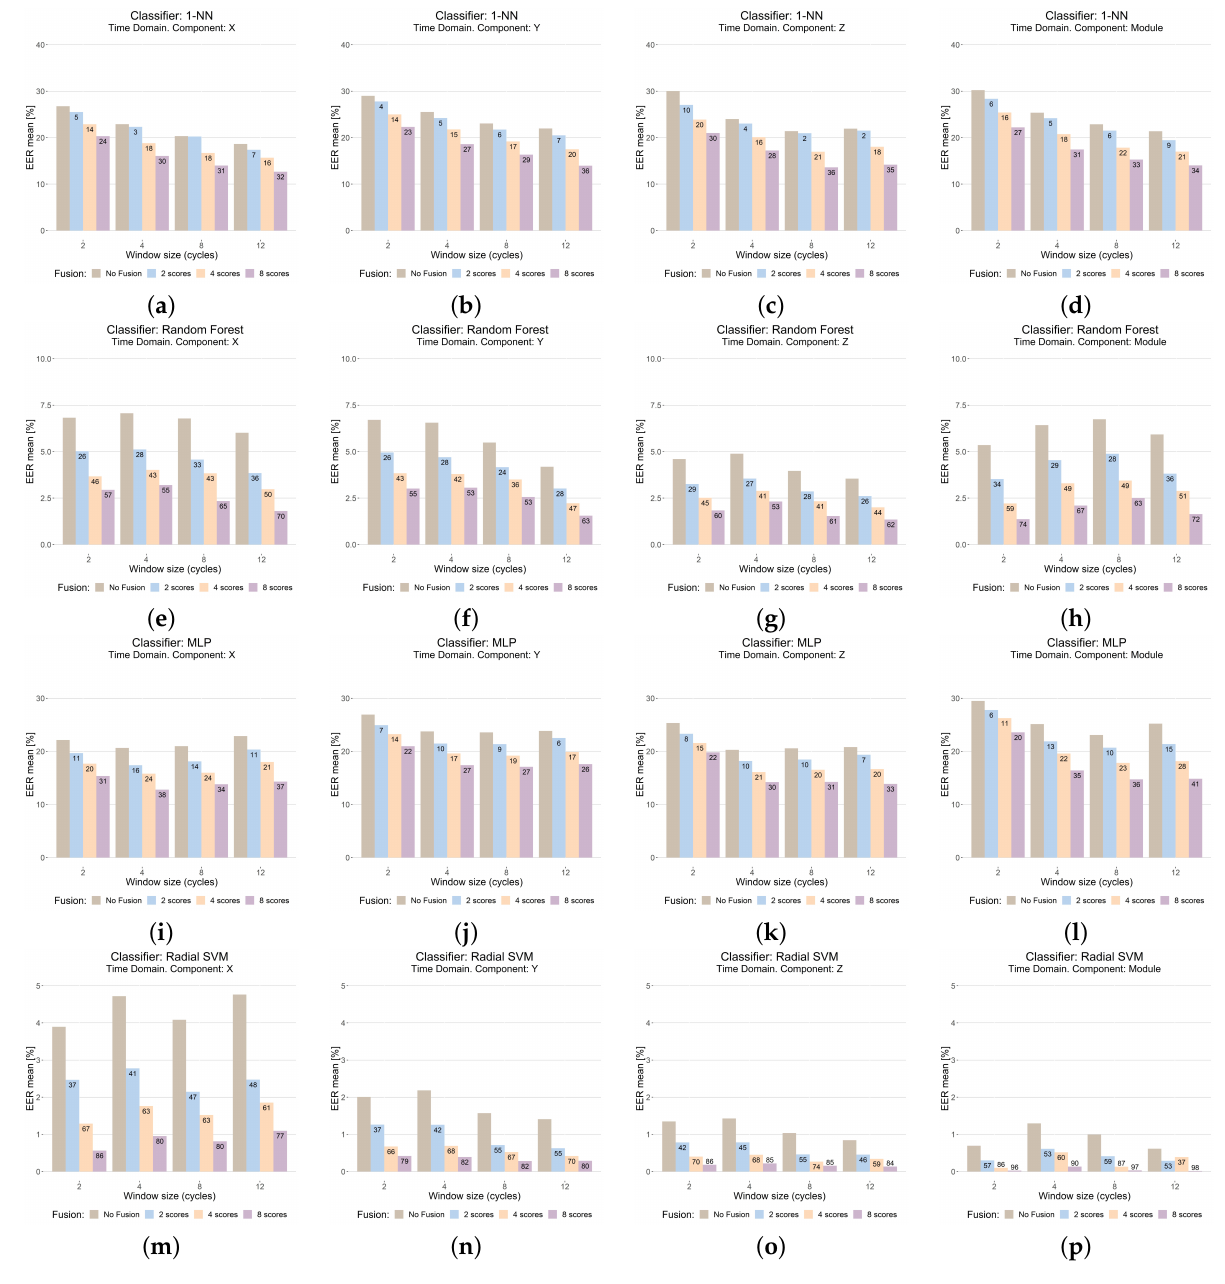
Figure 8. Results in the time